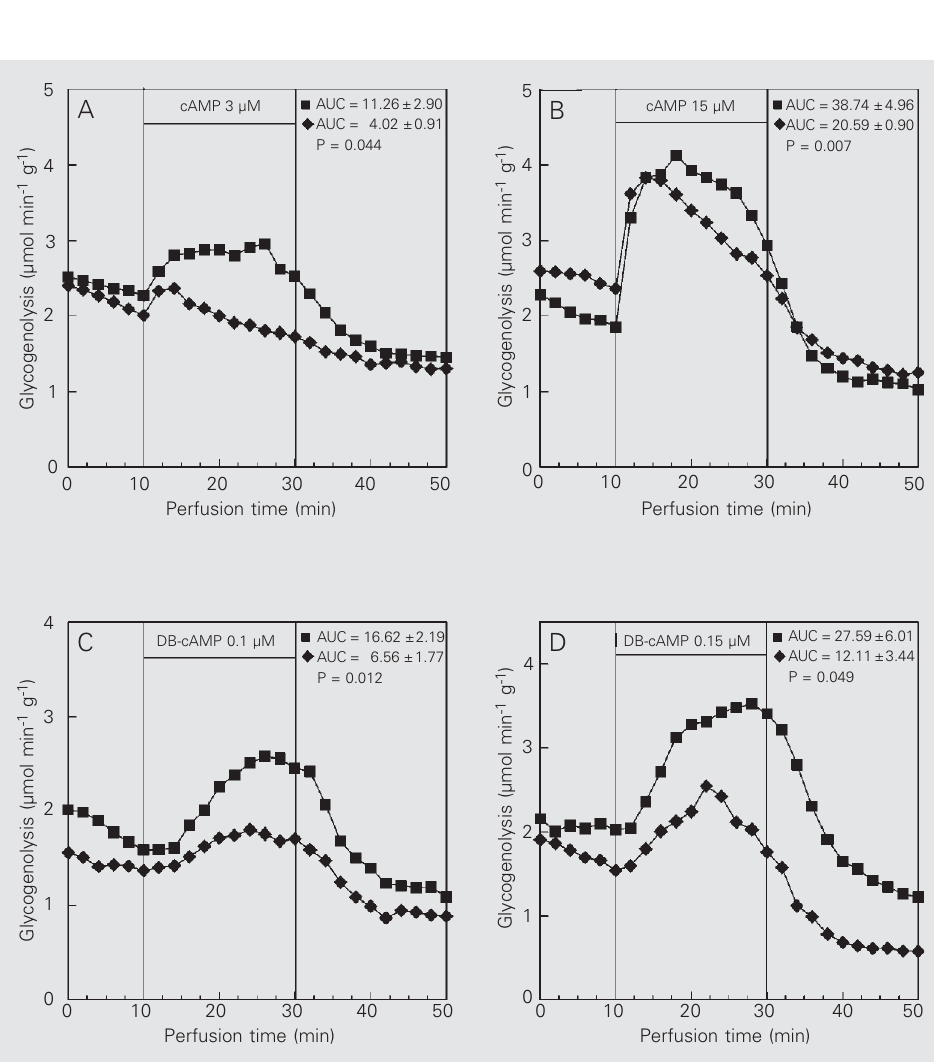
Figure 2. Effect of insulin on the activation of glycogenolysis pro- moted by adenosine-3'-5'-cyclic monophosphate (cAMP). The data are reported as the means ± SEM of 4 experiments. The areas under the curve (µmol/g liver fresh weight ± SEM) (cid:0) during the infusion of 3 µM cAMP (10- 25 min) and 3 µM cAMP + 500 µIU/ml insulin (25-35 min) were 12.81 ± 2.45 and 4.88 ± 1.51, respectively. The statistical test used was the unpaired Student t -test and the P value obtained was 0.033.